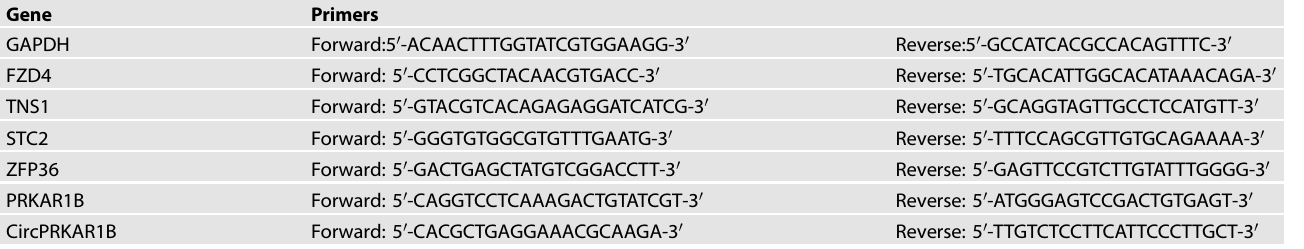
Table 1. Primers used in the study.